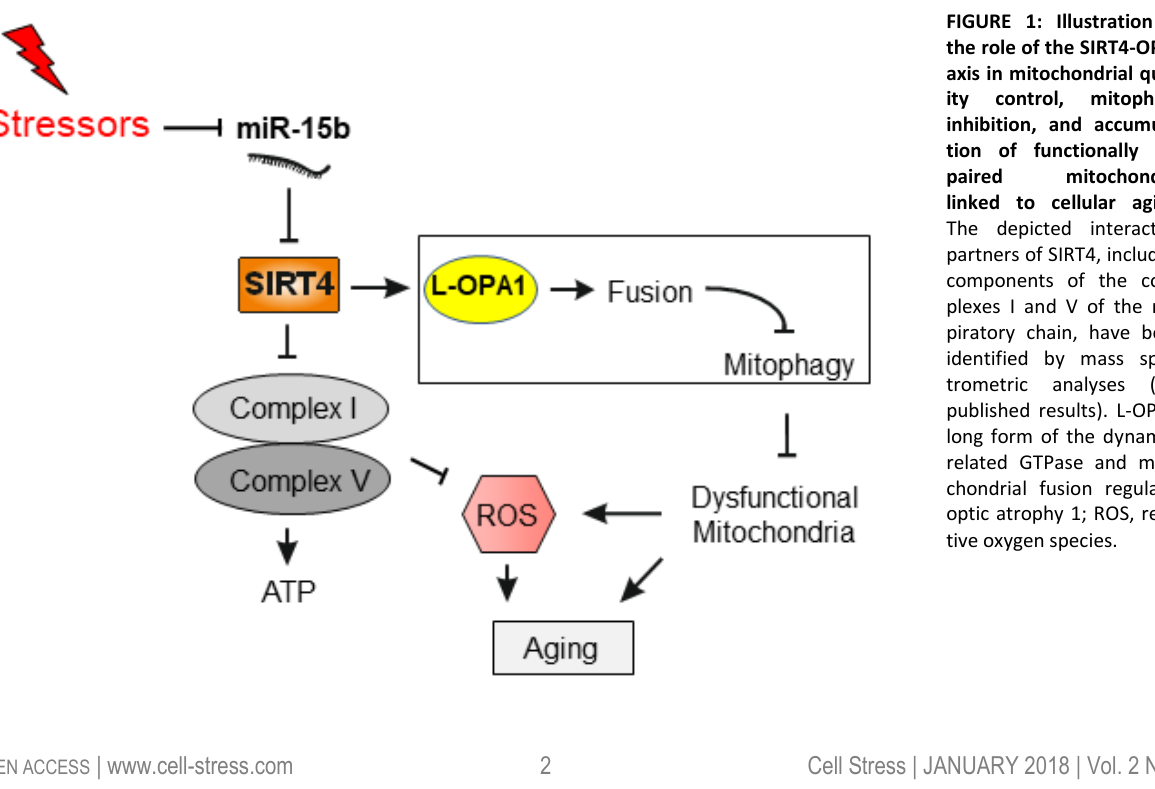
FIGURE 1: Illustration of the role of the SIRT4-OPA1 axis in mitochondrial qual- ity control, mitophagy inhibition, and accumula- tion of functionally im- paired mitochondria linked to cellular aging. The depicted interaction partners of SIRT4, including components of the com- plexes I and V of the res- piratory chain, have been identified by mass spec- trometric analyses (un- published results).